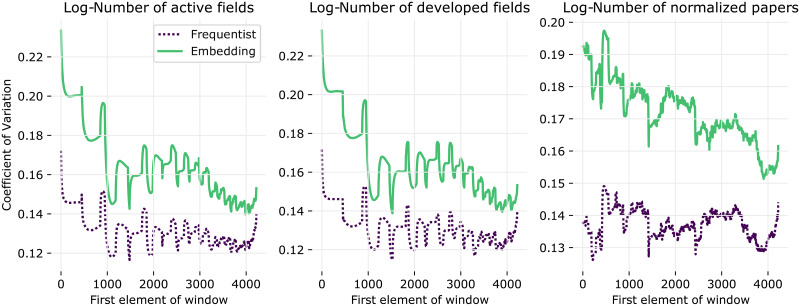
AUROC’s Coeff. of variation for institutions vs. data properties.Ratio between sample standard deviation and sample mean of the AUROC as a function of the (i) number of active fields, (ii) number of developed fields and (iii) normalized number of papers. Time windows are set as in the first experimental setup. Statistics are computed using a sliding window of size 1000 on the x axis.